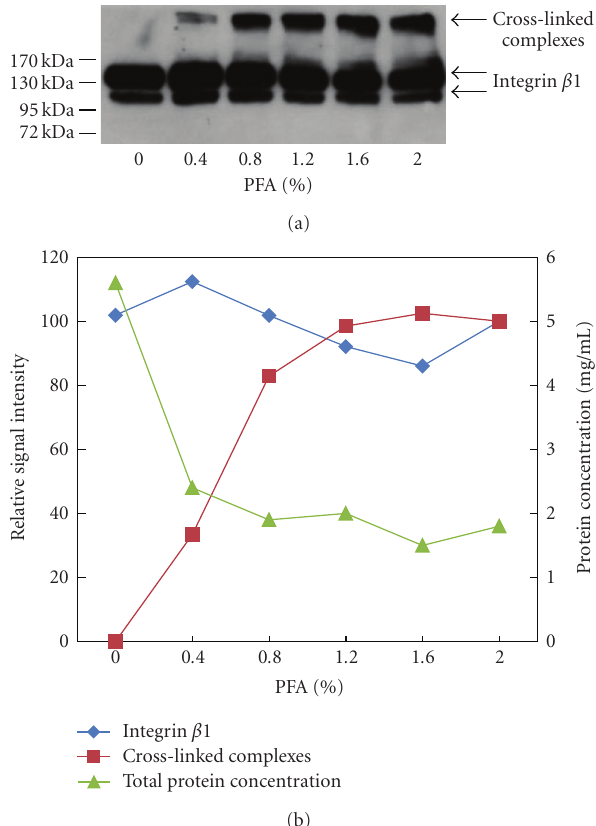
Figure 2: Optimization of formaldehyde concentration. Jurkat cells were treated with di ff erent concentrations of formaldehyde (PFA), lysed and the cell lysates were analyzed. (a) Anti-integrin β 1 immunoblot of lysates (JB1A, anti-mouse HRP). (b) Western Blot results were quantified using ImageJ. Values obtained at 2% PFA were set to 100% and relative intensities were calculated. Protein concentration of the lysates had been determined using a BCA assay. Total protein concentrations and relative signal intensities of the western blot analysis were plotted in one graph to show the correlation between the